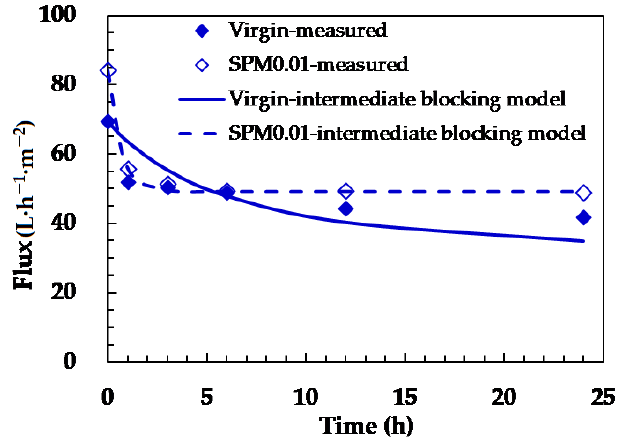
a Data from Suo and Ren (2021) [36]. b Fitting parameter for completely blocking. c Fitting parame- ter for intermediate blocking. d Fitting parameter for standard blocking. e Fitting parameter for gel layer formation.